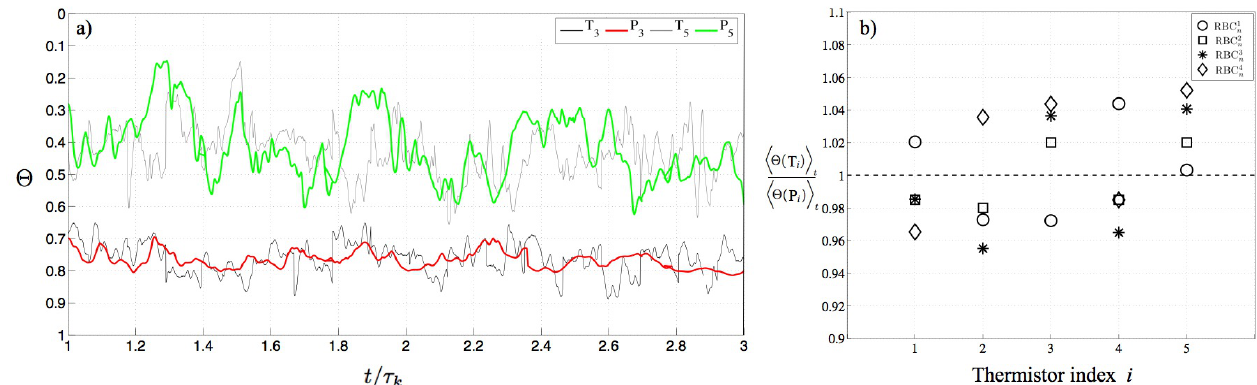
experiment and the corresponding l and P in numerical simulation RBC 2 3 5